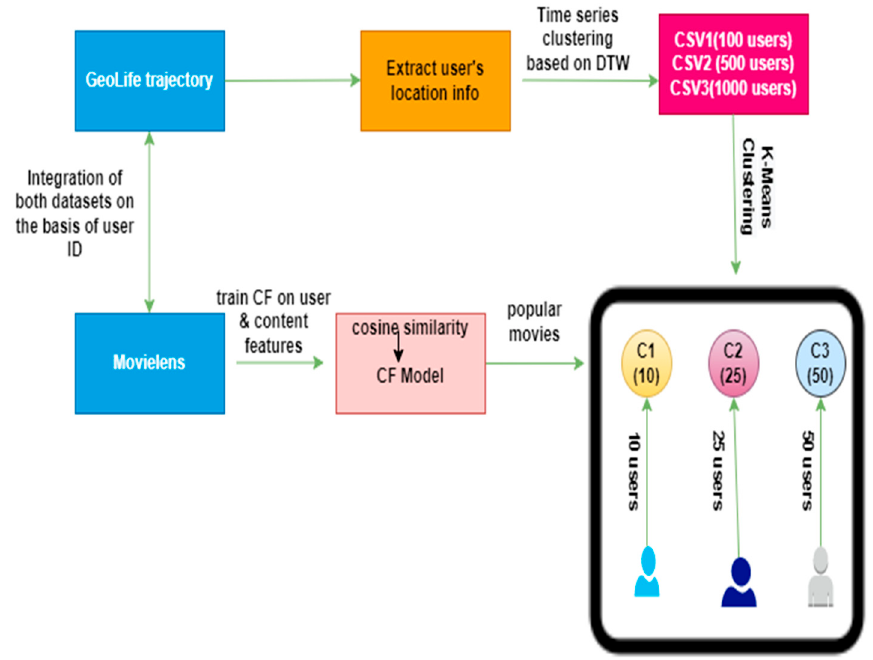
Figure 2. User preferences demonstration.